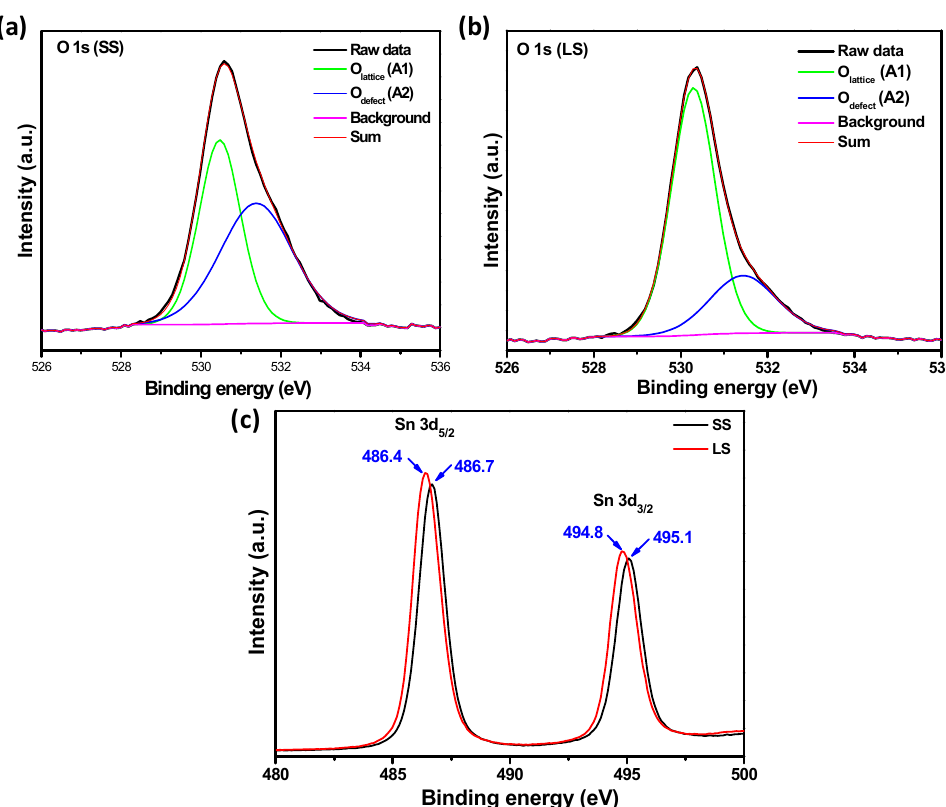
Figure 4. XPS data for the binding energies of ( a ) O 1s for the SS sample; ( b ) O 1s for the LS sample and ( c ) core levels of Sn 3d for both samples.